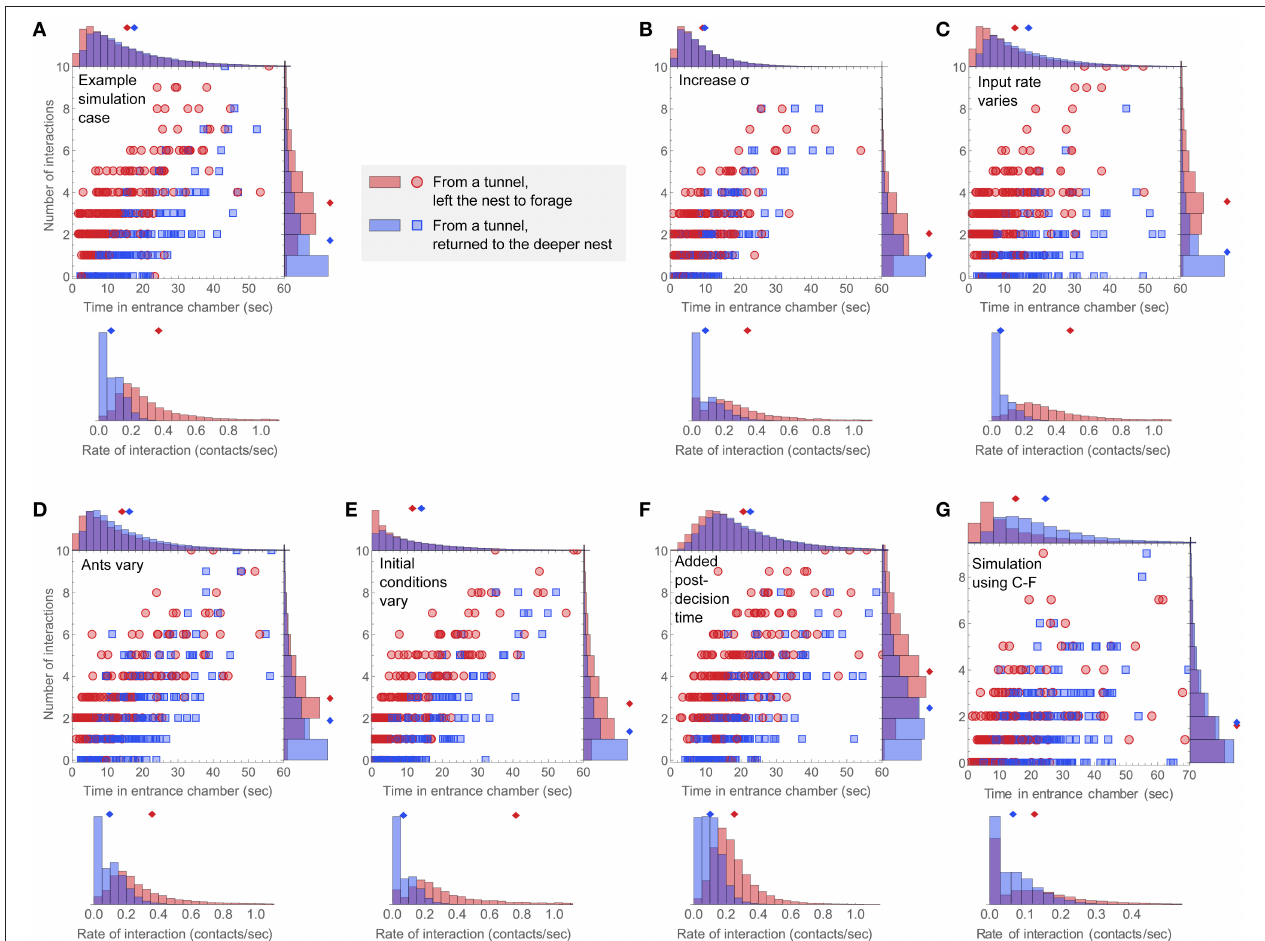
FIGURE 8 | Simulating sources of variability. For each case, the number of interactions vs. time in the entrance chamber is plotted for 400 simulated ants, and histograms for the distributions of number of interactions, time in the entrance chamber, and rate of interaction are shown for simulated ants in each group. (A) An example simulation using parameters k = 0.4, γ = − 0.06 , s 0 = 0, σ = 0.2, and r in = 0.15. (B–F) show perturbations to this case. (B) Increased noise in the decision variable, from σ = 0.2 to σ = 0.3. (C) The input Poisson interaction rate r in was drawn from a uniform distribution from 0 to r max in = 0.3 for each simulated ant. (D) The interaction sensitivity k and bias rate γ were drawn from normal distributions with mean values the same as in panel A, and standard deviations of 50% of the mean. (E) The initial decision state, s 0 , was drawn from a uniform distribution from − 0.75 to 0.75. (F) Simulated ants have an added post-decision time drawn from a uniform distribution of 0–10s., during which they continue to engage in interactions at the Poisson rate of r in = 0.15. (G) An example simulation including all of the added simulation mechanisms shown in (C–F) , with parameters chosen to resemble the observation of colony 2. The noise level is σ = 0.21 , the input rate of interaction was drawn from a uniform distribution from 0 to r max in = 0.16, the interaction sensitivity and bias rate were drawn from normal distributions defined by k = 0.14 ± 50 % and γ = − 0.038 ± 50 % , the initial decision state was drawn from a uniform distribution from − 0.2 to 0.8, and each simulated ant has an added post-decision time drawn from a uniform distribution from 0 to 5s, during which it continues to make interactions at a Poisson rate drawn from a uniform distribution from 0 to r max in =